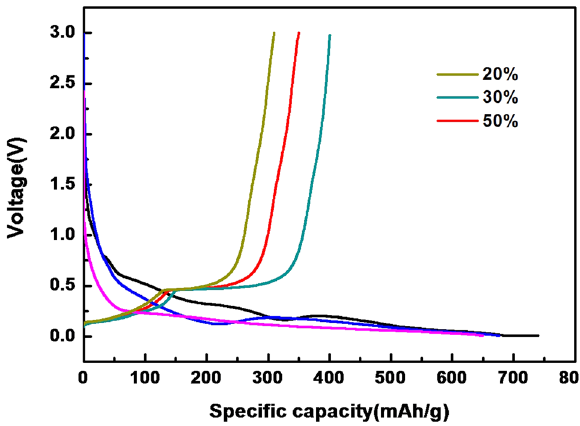
Figure 7: Charge – discharge curves of C@Al – EG composites as electrodes with di ff erent Al